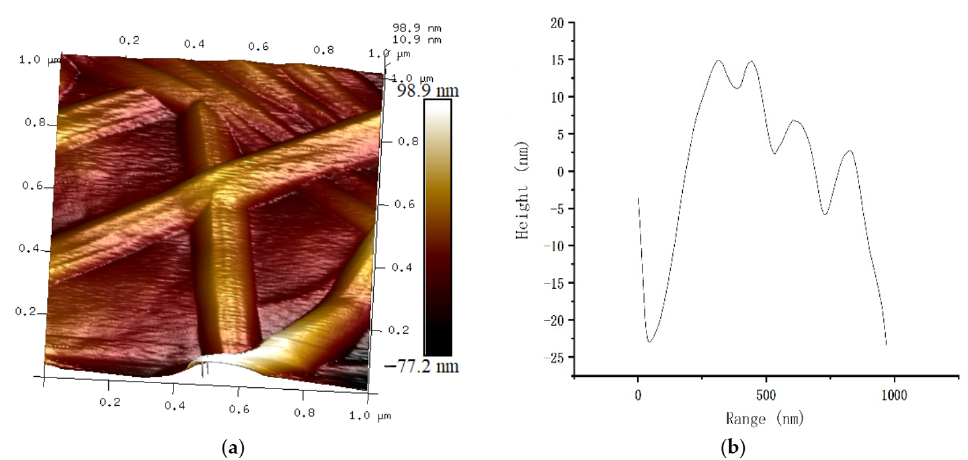
Figure 5. AFM images of double-layered AgNW film: ( a ) 3D image; ( b ) film step